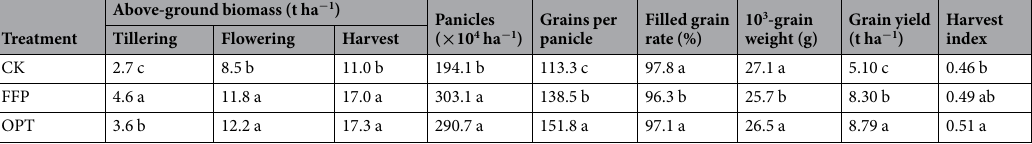
Table 3. Average biomass, yield components and harvest index of N managements across six sites in Jiangsu in 2008–2013.